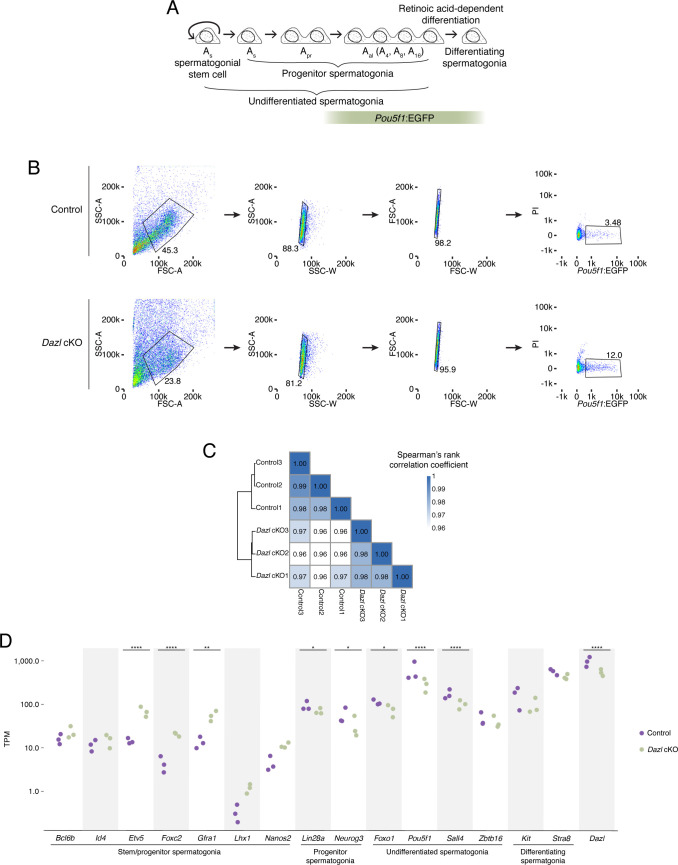
Characterization of Pou5f1:EGFP-positive spermatogonia in Dazl cKO.(A) Schematic of spermatogenesis from undifferentiated spermatogonia through differentiating spermatogonia, with expression of Pou5f1:EGFP. (B) Schematic depicting the sorting strategy used to isolate Pou5f1:EGFP-positive spermatogonia from control and Dazl cKO adult testes. The GFP+ population (right panel) was collected for RNA-seq. (C) Heatmap of sample-to-sample distances among RNA-seq datasets of sorted Pou5f1:EGFP-positive spermatogonia from control and Dazl cKO testes. Three biological replicates were analyzed for each genotype. (D) Differential gene expression analysis of RNA-seq analysis of Pou5f1:EGFP-positive spermatogonia from adult testes, highlighting genes associated with spermatogonial stem cells and early progenitors (‘stem/progenitor spermatogonia’), progenitor spermatogonia, undifferentiated spermatogonia (i.e., spermatogonial stem cells as well as early and late progenitors), and differentiating spermatogonia. * adjusted p<0.05, ** adjusted p<0.01, *** adjusted p<0.001, **** adjusted p<0.0001.